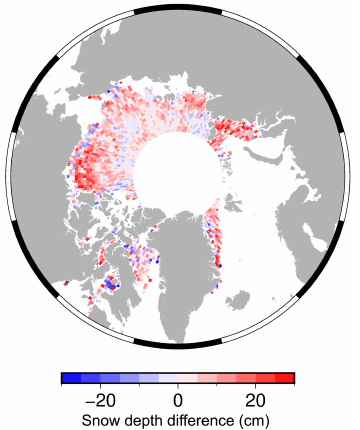
Figure 5. April 2016 minus November 2015